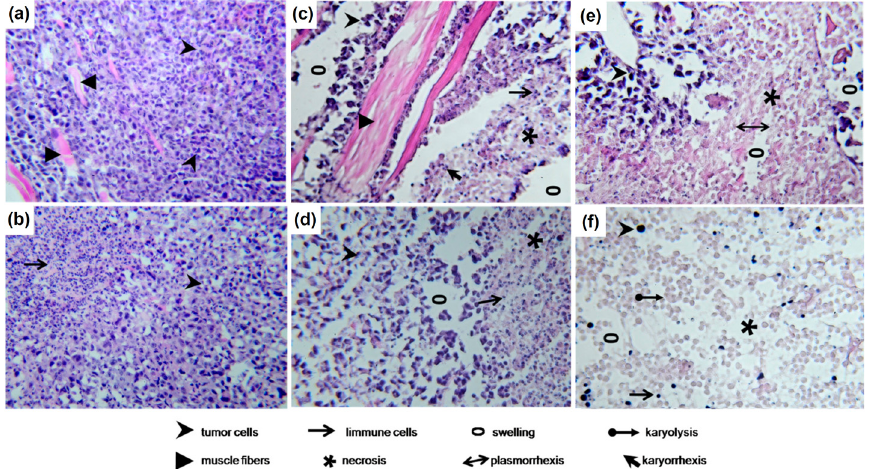
Figure 10. Histological features of the treated tumors: ( a ) nontreated tumor; ( b ) tumor treated with aptamers alone; ( c , d ) tumor treated with FrFeAG and LFAMF; ( e , f ) tumor treated with AS-FrFeAG NPs under an LFAMF. Magnification x 100. Adapted from reference [36].